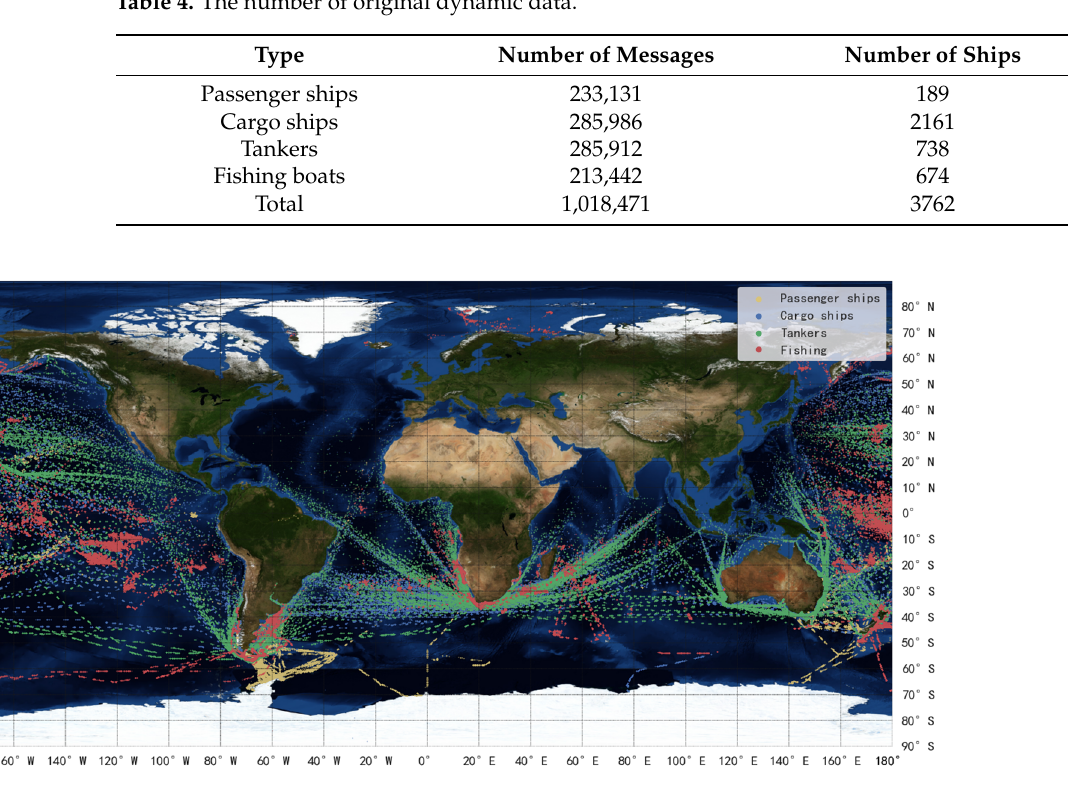
Figure 14. The integration process of base classifiers.